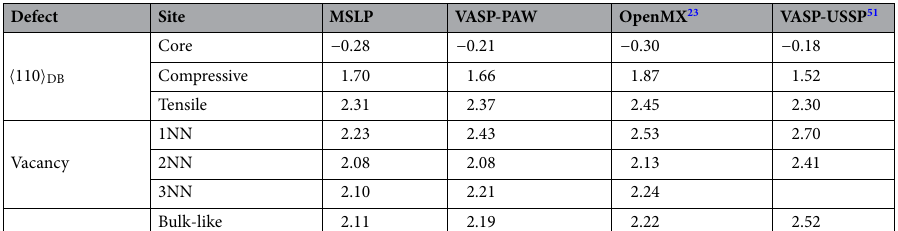
110 dumbbell self-interstitial atom and vacancy (cid:31) (cid:30)